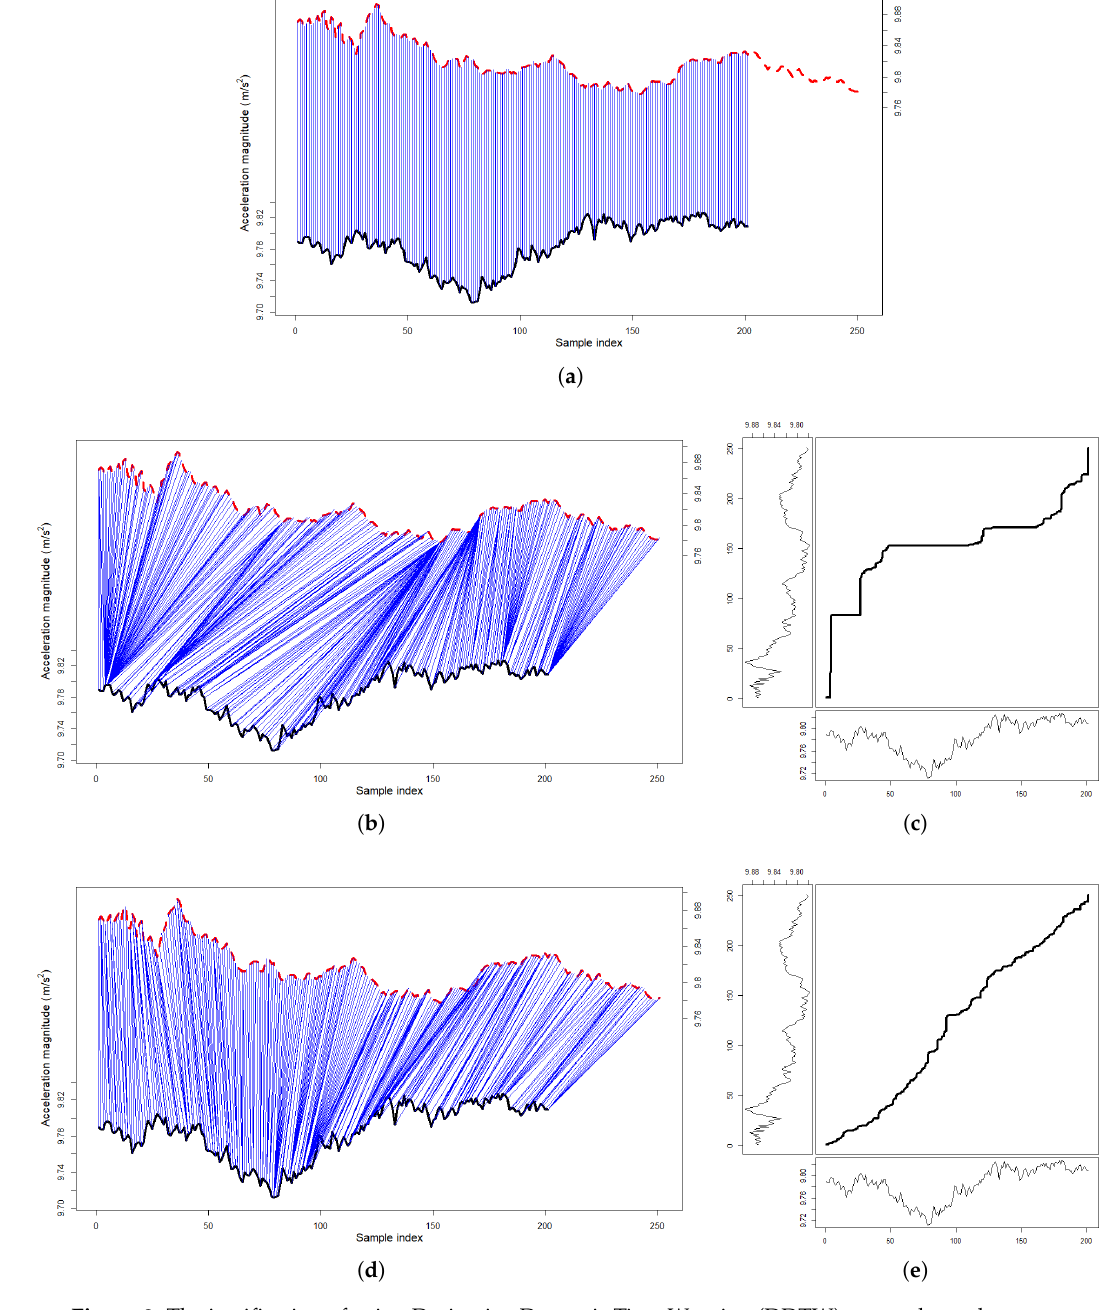
Figure 9. The justification of using Derivative Dynamic Time Warping (DDTW) to match accelerometer traces: Euclidean distance-based matching fails to align traces of various lengths. Standard Dynamic Time Warping (DTW) overwarps the X -axis when the variability on the Y -axis is high. ( a ) Euclidean alignment; ( b ) DTW alignment; ( c ) DTW warping path; ( d ) derivative DTW alignment; and ( e ) derivative DTW warping